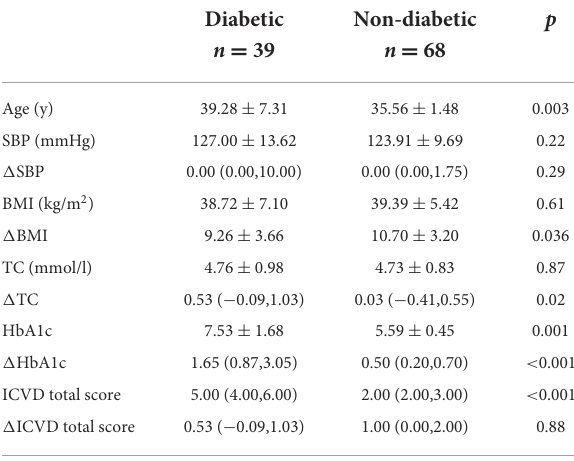
TABLE 7 Baseline characteristics and reduced clinical characteristics 6 months after surgery: differences between diabetic and non-diabetic